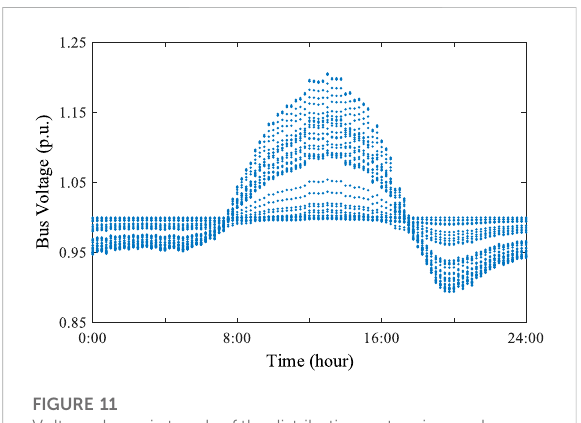
FIGURE 9 Measured distributed PV data of the typical day.